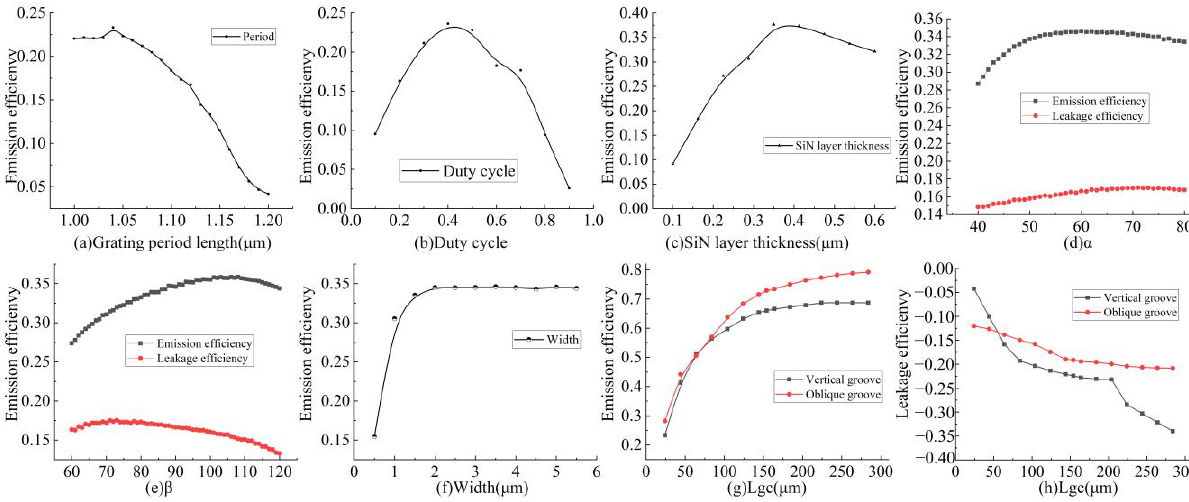
Figure 3. Optimization results of parameters affecting the emission efficiency of the proposed antenna. ( a ) The emission efficiency in relation to grating coupler period length; ( b ) the emission efficiency in relation to grating coupler duty cycle; ( c ) the emission efficiency in relation to SiN layer distance with Si waveguide; ( d ) the emission efficiency in relation to grating coupler etch α angle; ( e ) the emission efficiency in relation to grating coupler etch β angle; ( f ) the emission efficiency in relation to grating area width Wgc; ( g ) curve of grating area length Lgc versus emission efficiency and its comparison with the emission efficiency of vertically etched antenna; ( h ) curve of grating area length Lgc versus leakage efficiency and its comparison with the emission efficiency of vertically etched antenna.